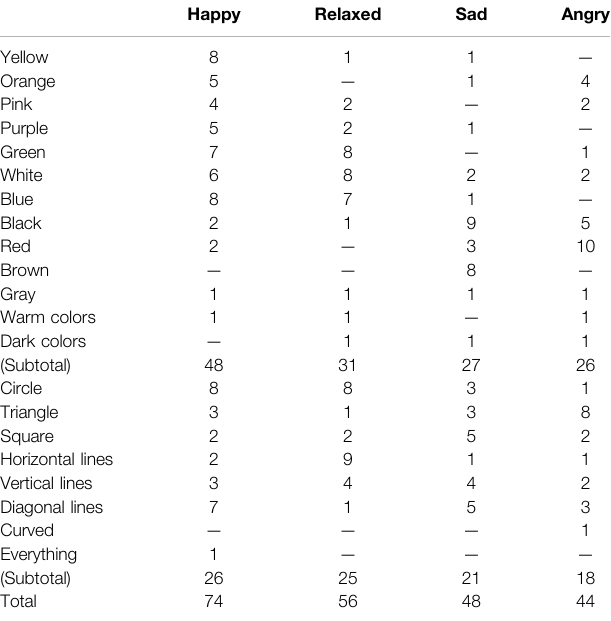
TABLE 3 | Abstract art elements disclosed by participants as eliciting emotions. Happy Relaxed